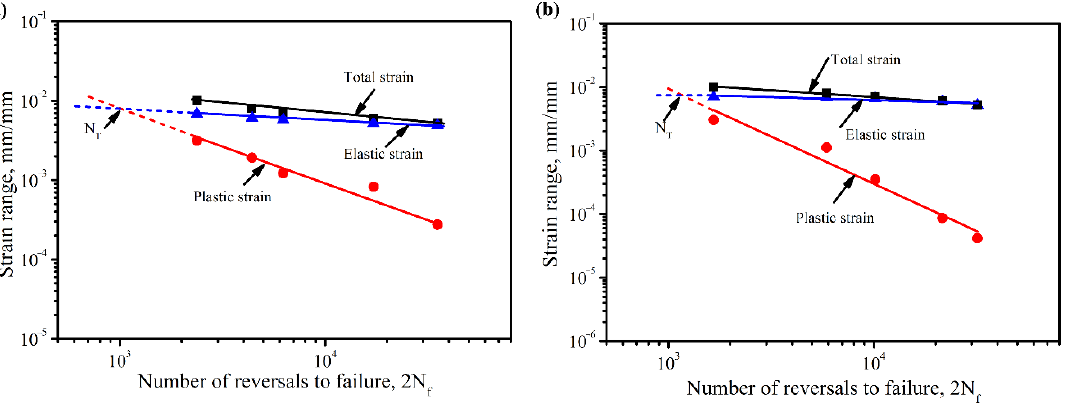
Figure 6. Plastic strain amplitude, elastic strain amplitude and total strain amplitude versus the number of reversals to failure of ( a ) 22MnSi2CrMoNi and ( b ) 00Ni18Co9Mo4Ti steels.